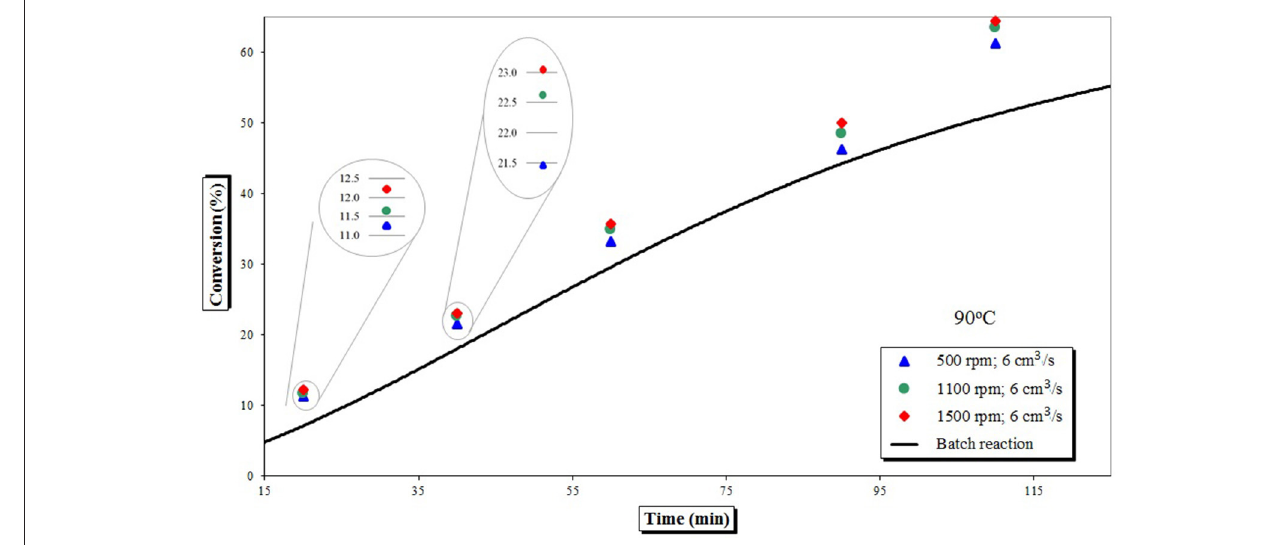
FIGURE 3 | Conversion improvements in a SDR compared to a batch process.